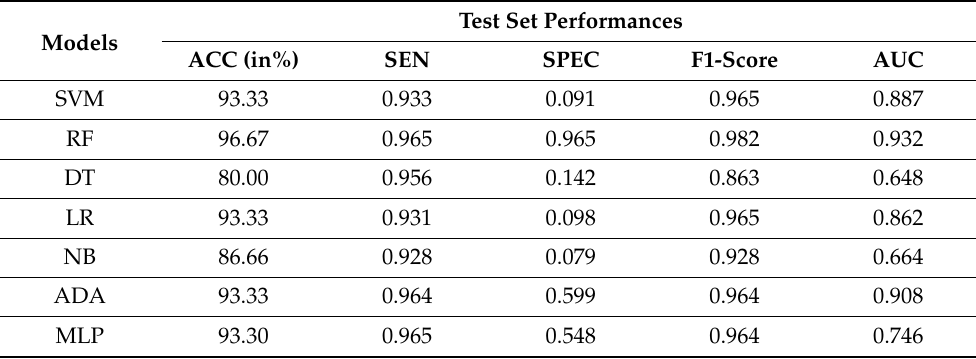
Table 5. Performance with imbalanced data set using hold-out